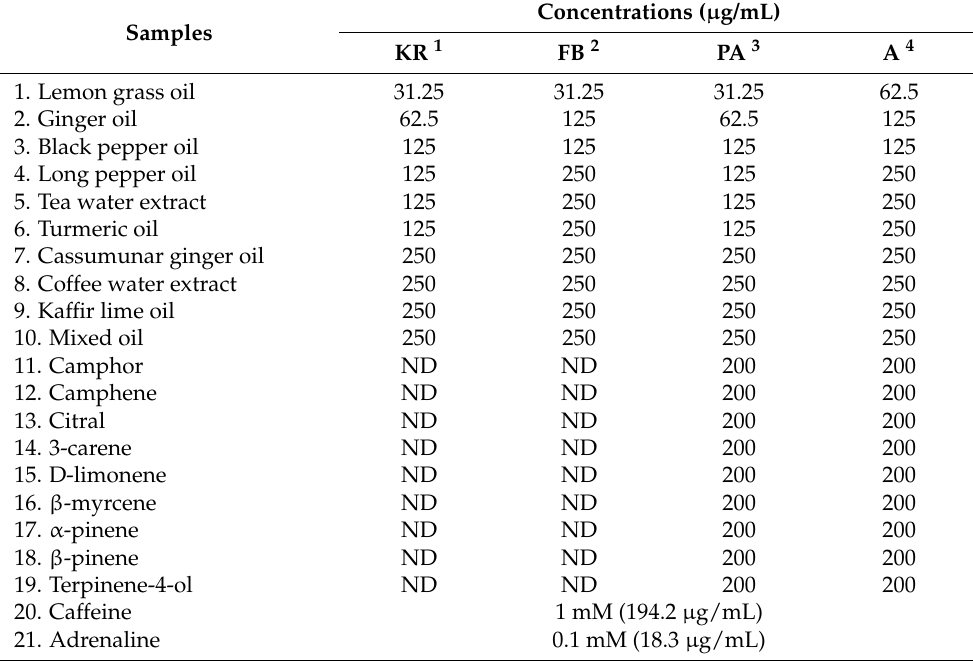
Table 1. Non-toxic concentrations of 7 essential oils, mixed oil, tea and coffee extracts, and their major constituents in anti-cellulite herbal compress selected from 3-(4,5-dimethylthiazol-2-yl)-2,5- diphenyl-tetrazolium bromide (MTT)